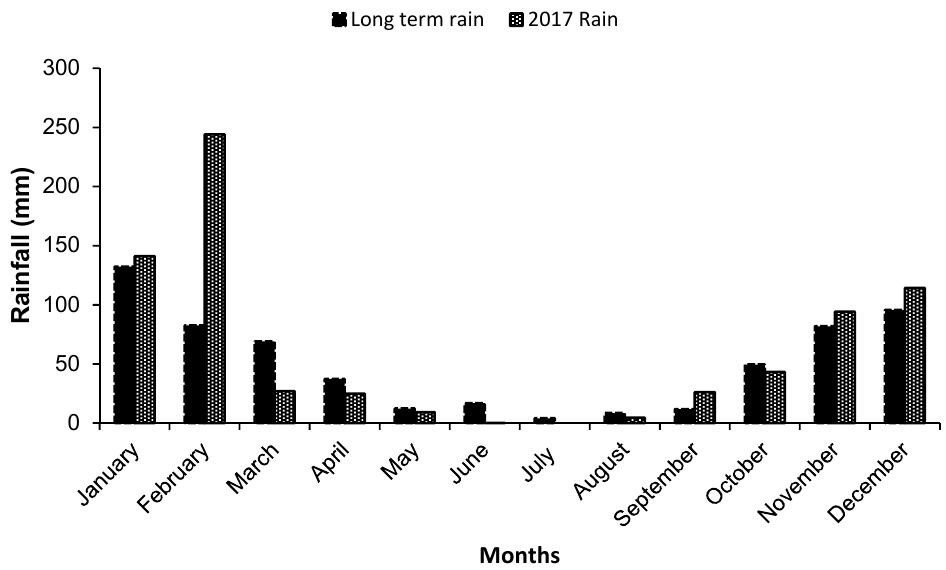
Figure 2. Rainfall conditions at the Bethlehem long-term trial site.